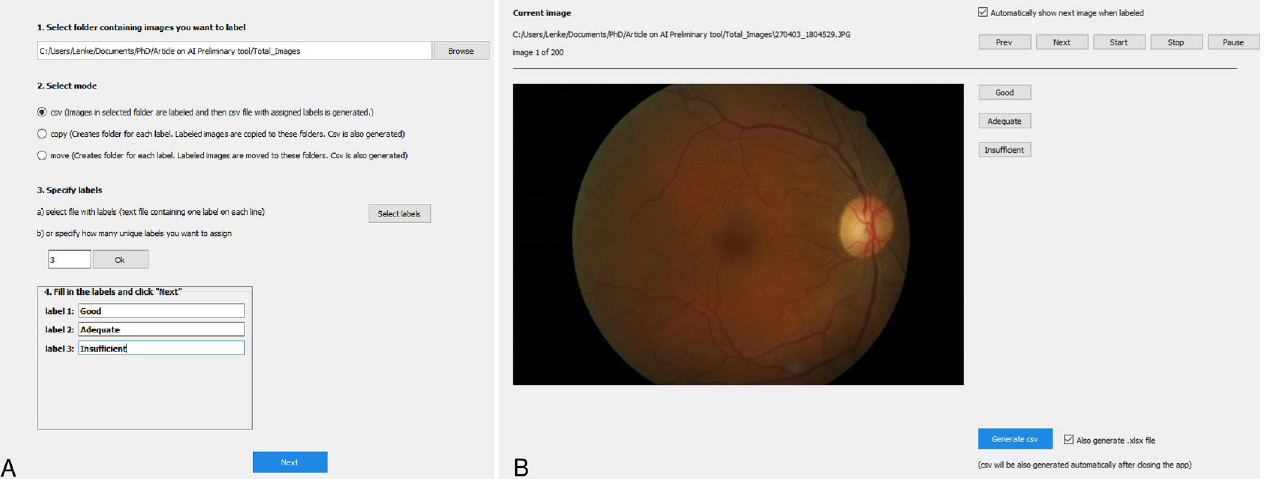
Fig 2. Screenshots of the image labeling tool developed in Python demonstrating its function. A) First, the folder containing the images is selected (1). In the next step the output of image labeling can be chosen (2) and finally the labels are specified (3). B) After setting the above parameters there are two options. Either navigate through with the “Prev” and “Next” buttons, or run a timed labeling round by selecting the option to “automatically show next image when labeled” and then the “Start” button. Upon closing the tool, a.csv and optionally.xls will be generated with the results.